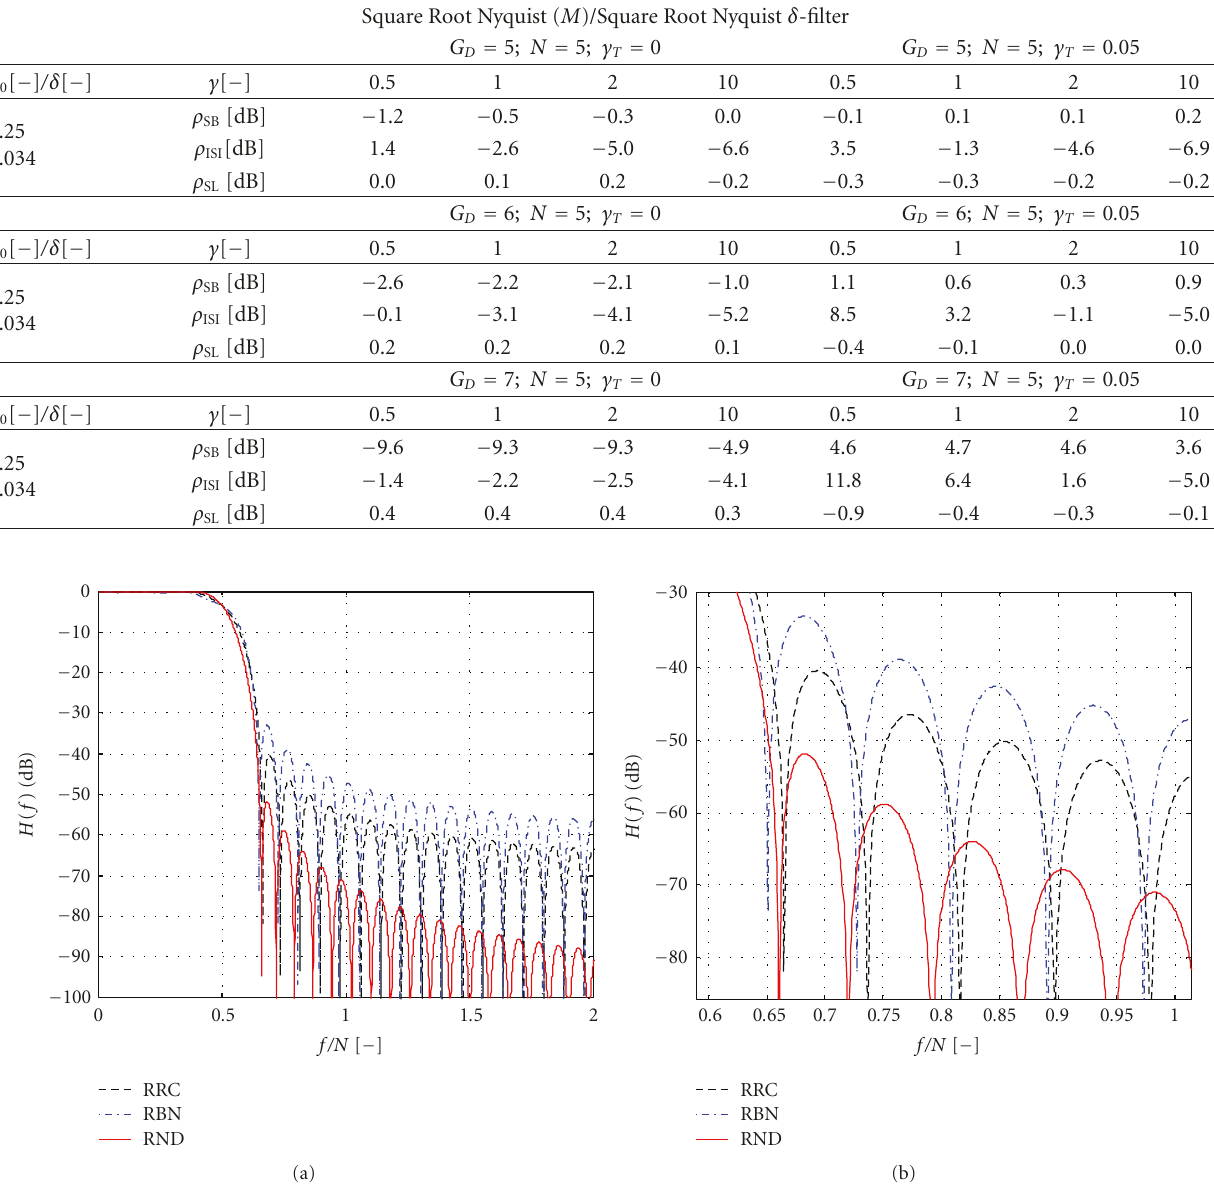
Figure 6: Amplitude frequency characteristics (log scale) of the truncated square root RC filter (RRC); square root B -filter (RBN); square root Nyquist δ -filter (RND) of the same filter order and equivalent excess bandwidth α = 0 . 284; G D = 6; N = 5; N O =